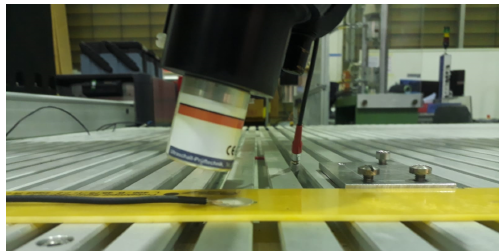
Figure 6. GFRP strip specimen with attached actuator and microphone above for detecting GUW propagation using air-coupled ultrasonic technique. The microphone depicts a variation of the probe angle. The inclination additionally enables the detection of in-plane proportions compared to a perpendicular setup, which is only sensitive to out-of-plane